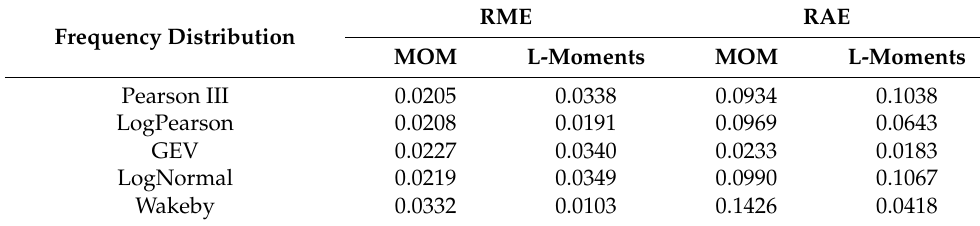
Table 7. RME and RAE score values for the Ialomita